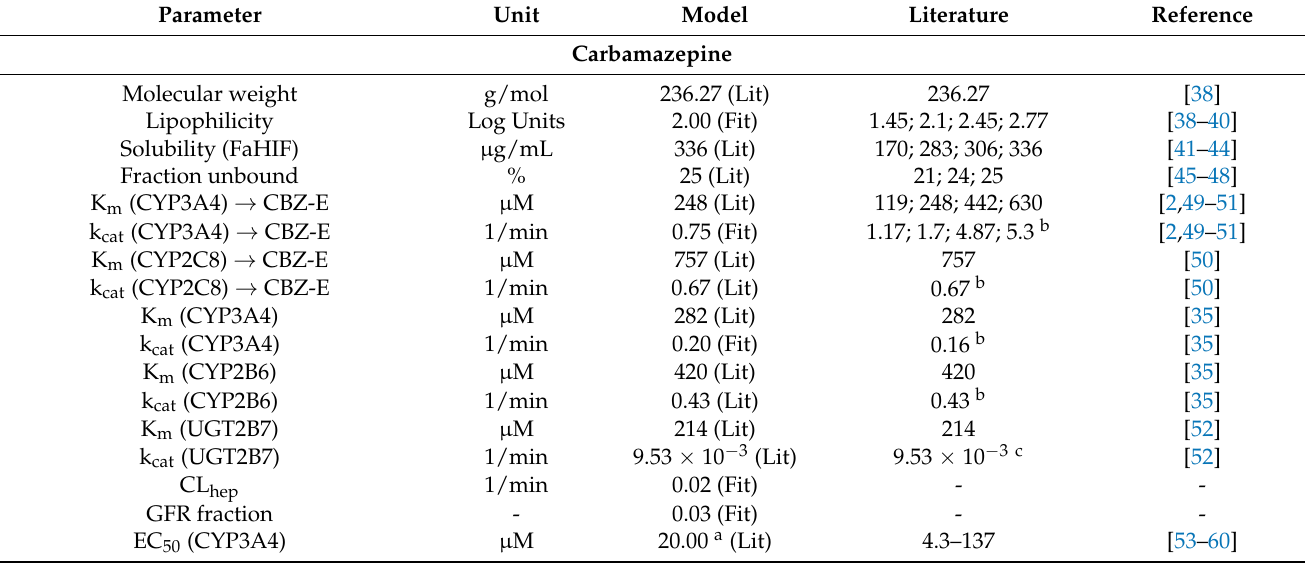
Table 1. Drug-dependent parameters of carbamazepine and carbamazepine-10,11-epoxide.